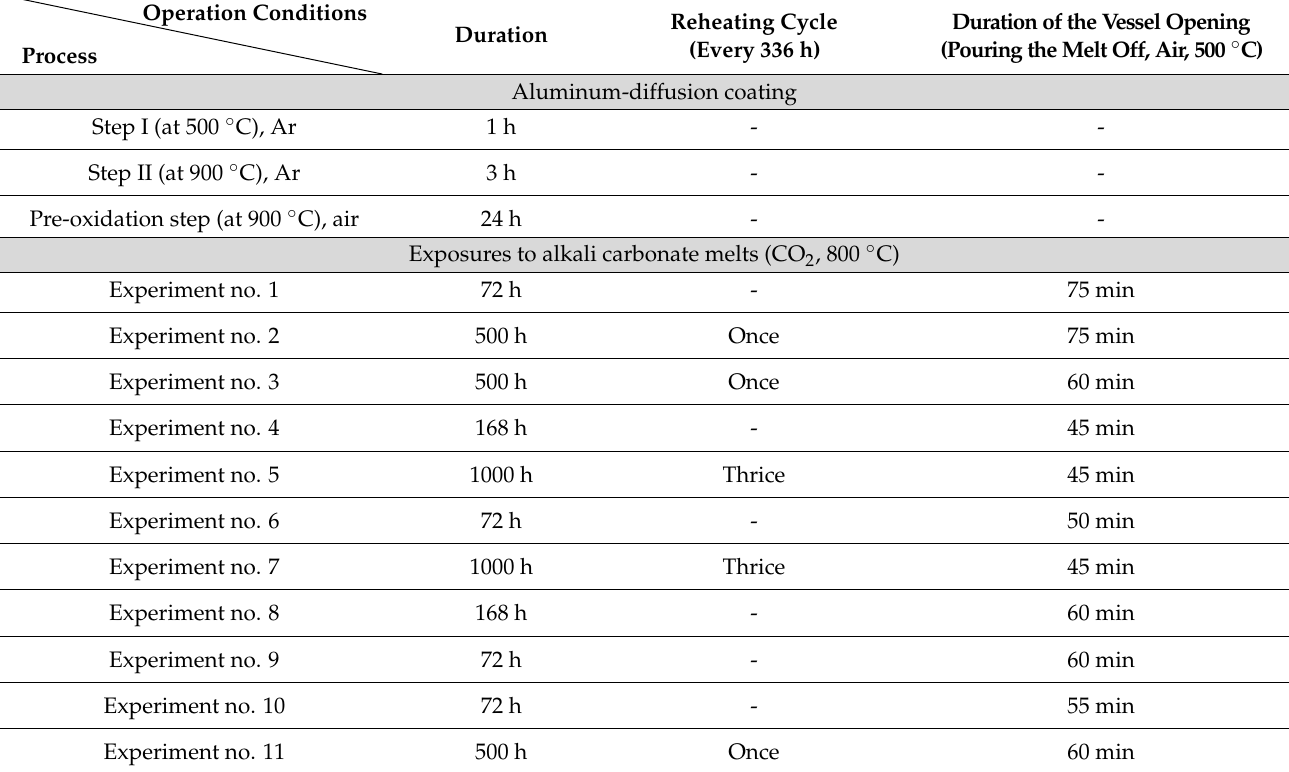
Table 2. Lifecycle of the investigated vessel and the operation